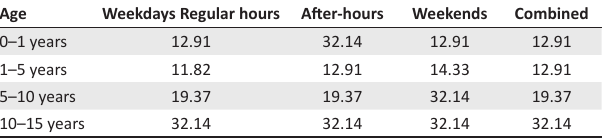
TABLE 3: 75th percentile Computed Tomography Dose Index data distribution, categorised for time and age for computed tomography brain examinations at Charlotte Maxeke Johannesburg Academic Hospital ( n = 515).